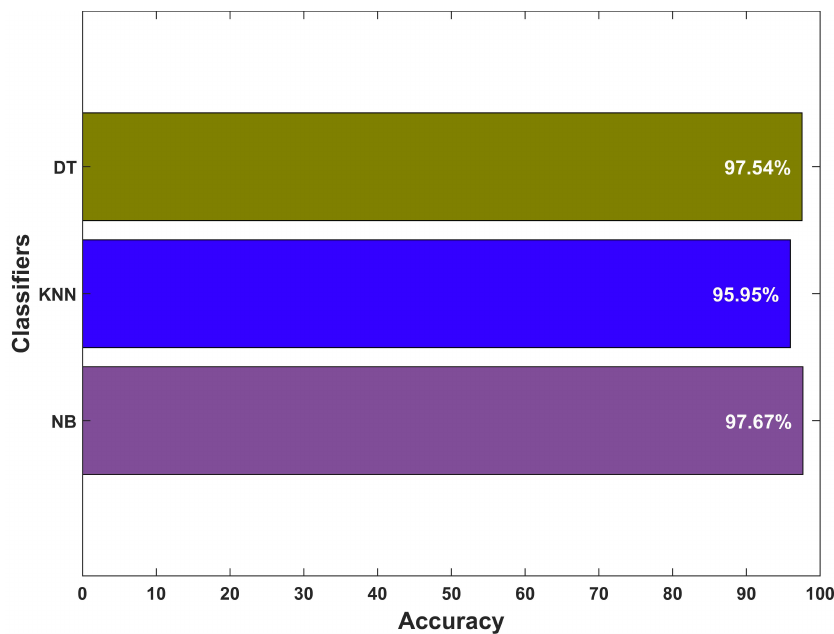
Figure 17. Results for floor change